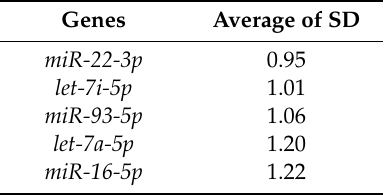
Figure 5. Graph showing stability of selected miRNAs analyzed by Best Keeper. Table 6. Average standard deviation result of selected miRNAs calculated by Best Keeper software.